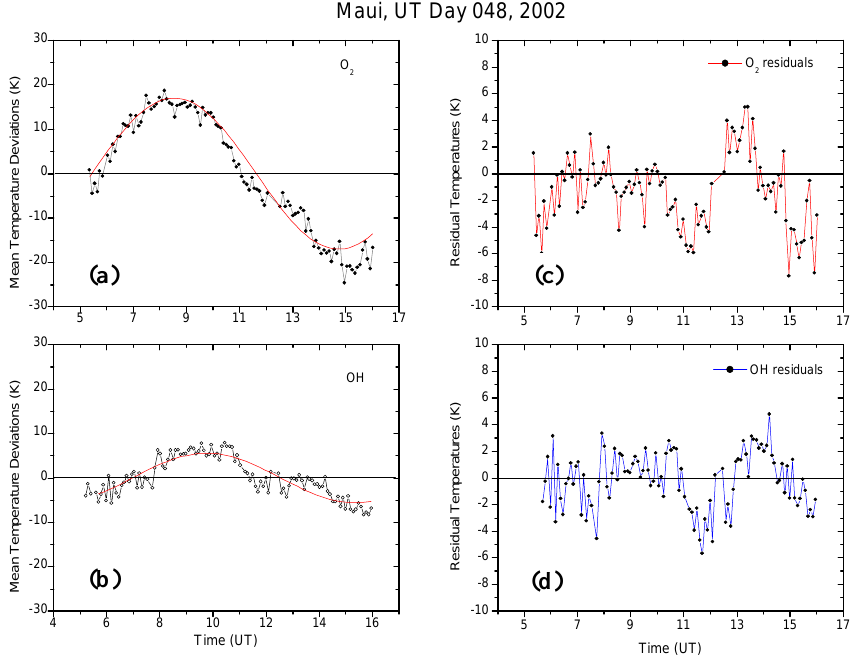
Fig. 3. (a, b) The mean temperature deviations for the O 2 emissions and OH emissions on UT day 48, 2002. The solid line curve is the result of a best-fit sinusoidal analysis. A long period tide-like oscillation is evident in the data with periodicity of about 12h. The temperature residuals are plotted in the right panels (c, d) . Note the large variations in the smaller period wave perturbations with periods ranging from 10min to